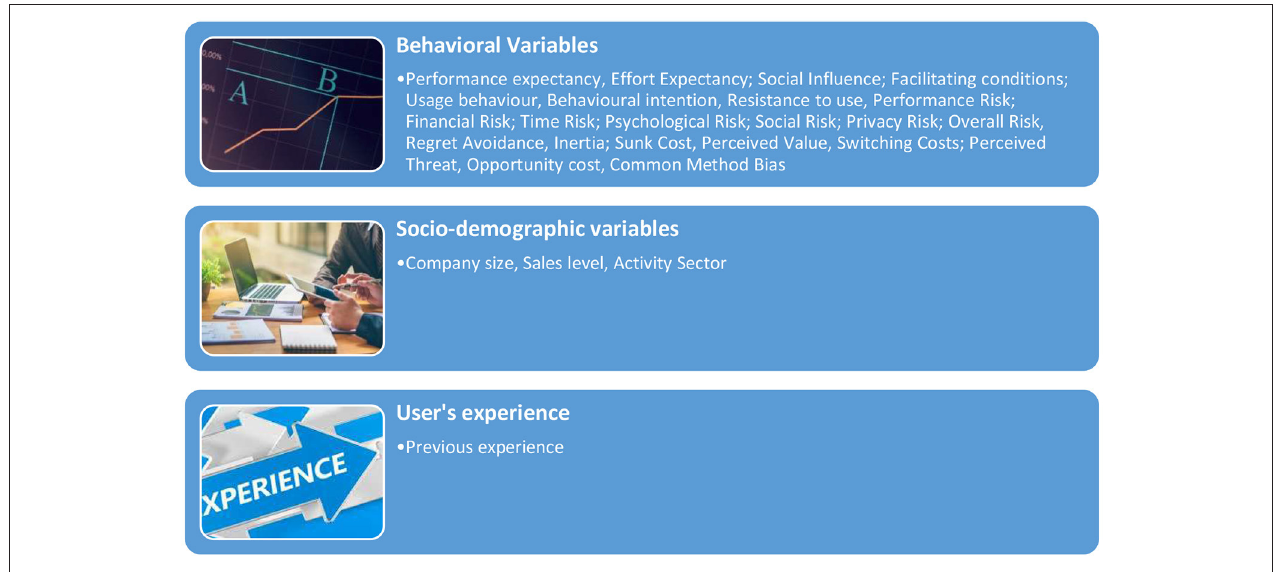
FIGURE 2 | Variables